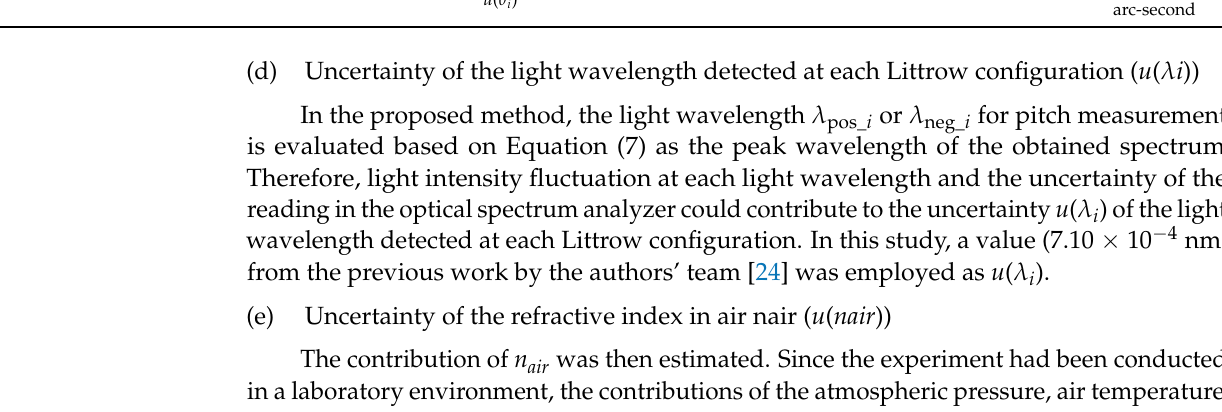
uncertainty source to u ( θ i ). (d) Uncertainty of the light wavelength detected at each Littrow configuration ( u ( λ i )) Table 2. Uncertainty of the detection of the i th positive or negative first-order Littrow angle θ i . Sources of Uncertainty Symbol Type Stability of the angular output Resolution of rotary encoder